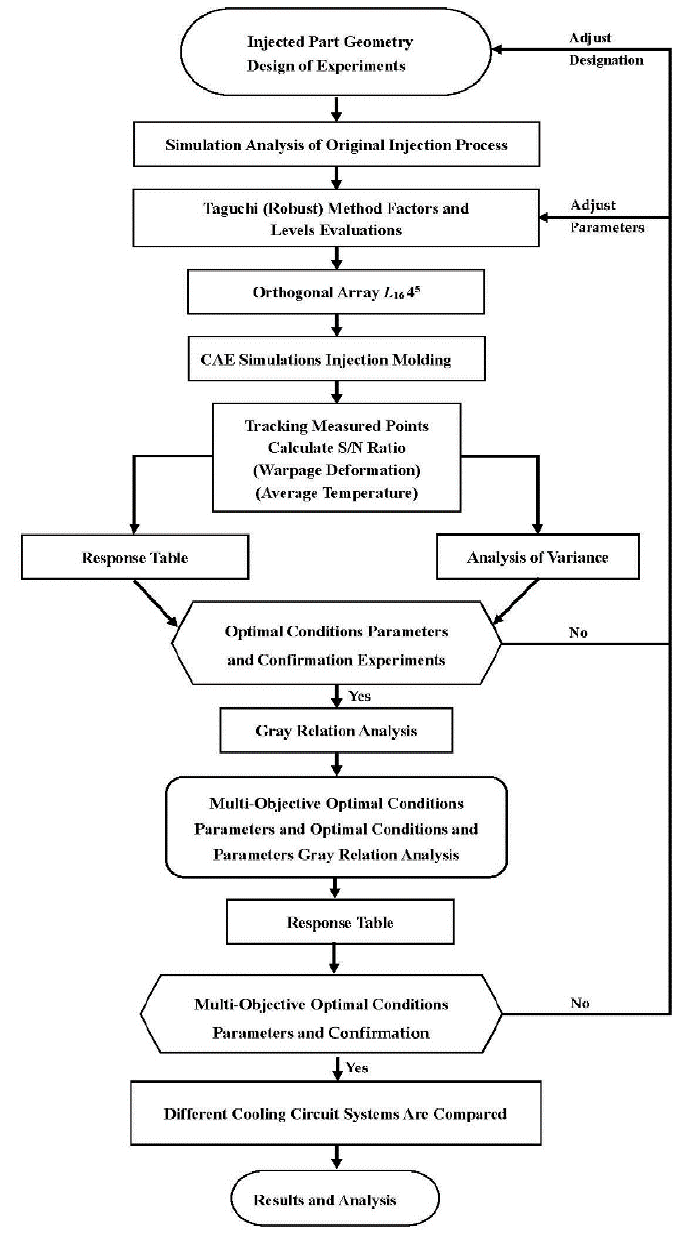
Figure 5. Overall Flowchart of Experiment.